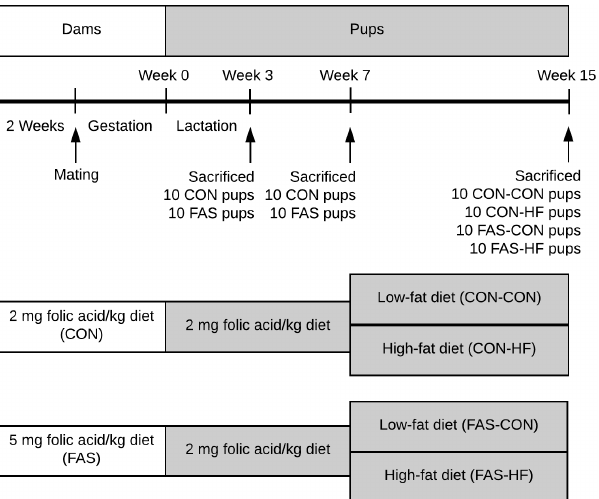
Figure 1. Flow diagram of study design. At weaning (Week 3), 40 CON and 40 FAS male pups were randomly selected from different litters for the following experiments. The rest of male pups and all female pups were sacrificed as this time point. Abbreviations: CON, control; FAS, folic acid supplementation; HF, high-fat diet.